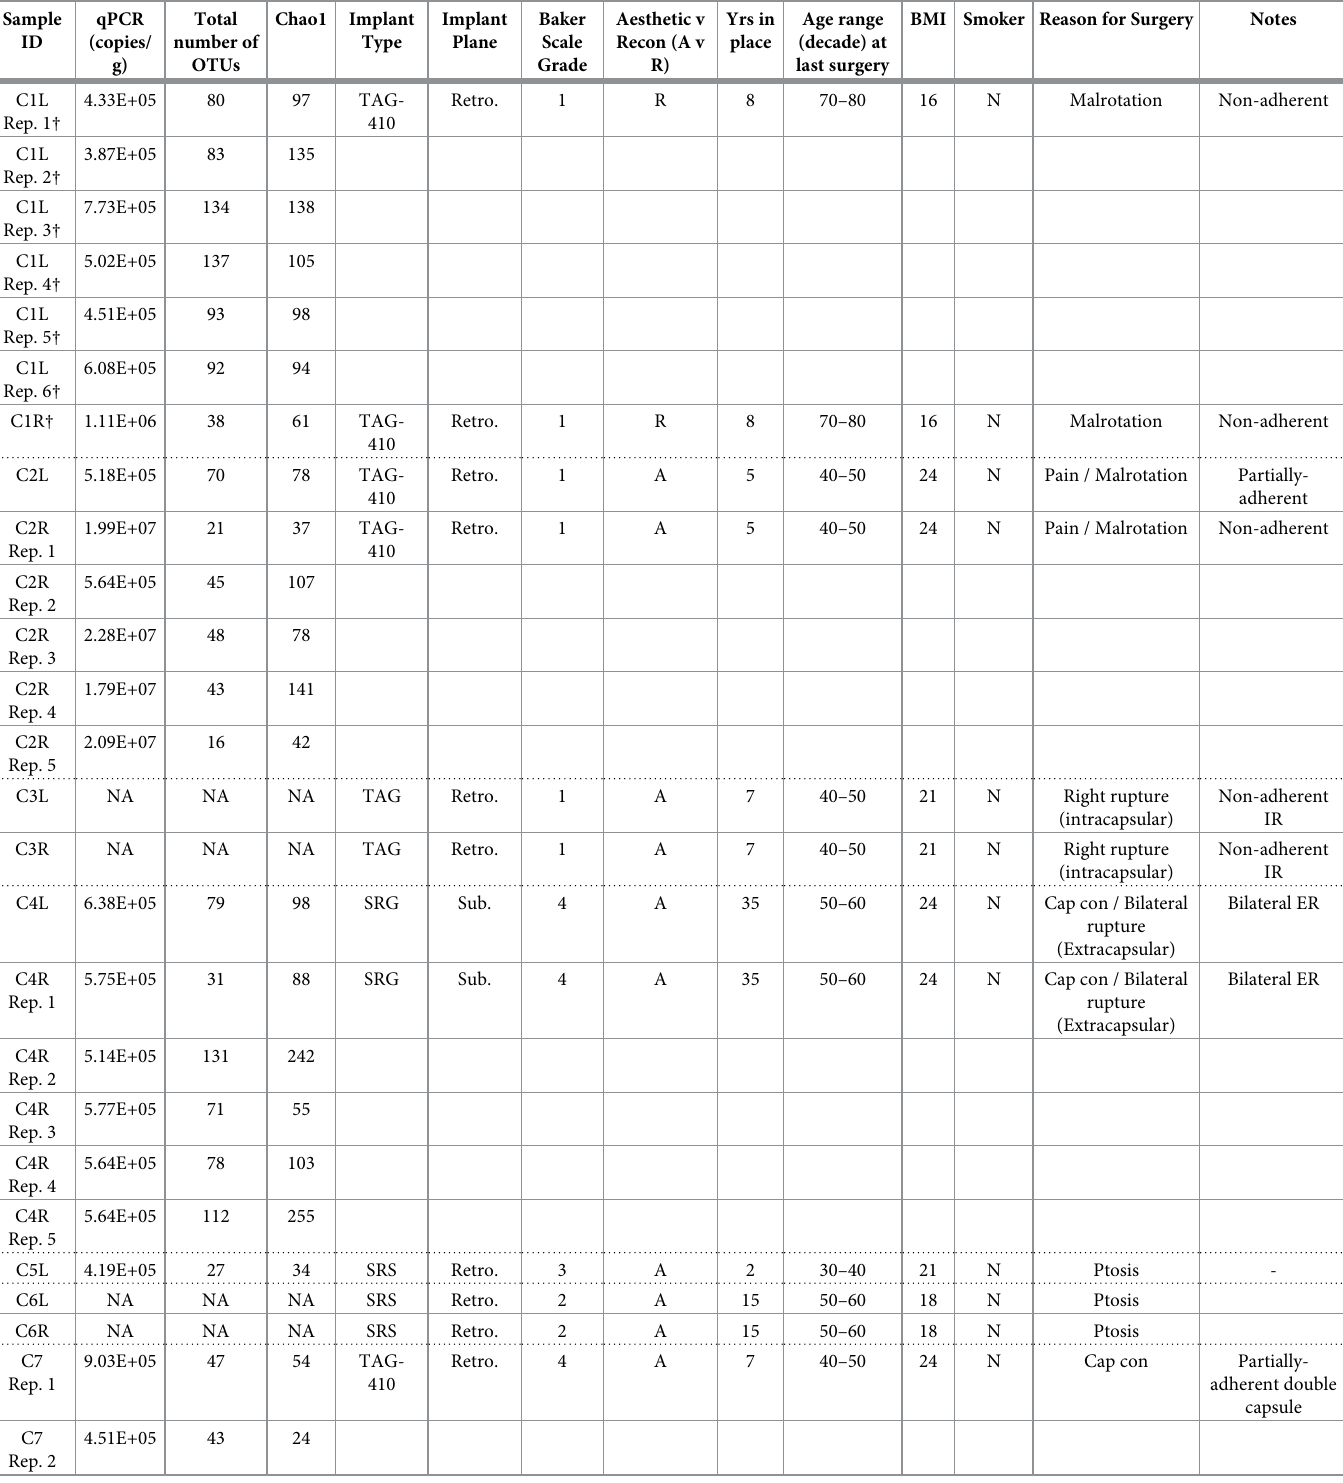
Table 1. Capsular samples, qPCR quantification of the capsular tissue microbial load (gene copies per gram of tissue), respective number of sequences analyzed, observed sequences, chao 1 alpha diversity indices, implant type, and Baker scale rating. Sample